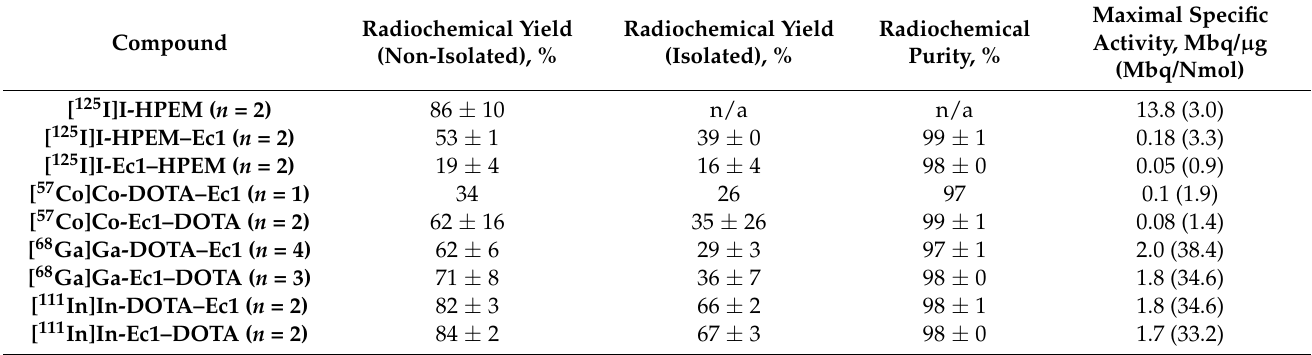
Table 1. Results of radiolabeling of Ec1